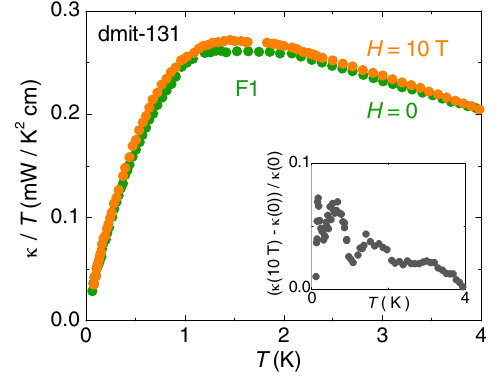
FIG. 7. Thermal conductivity of our sample F1, plotted as κ =T vs T , in both zero field (green) and at H ¼ 10 T (orange), revealing a weak field dependence up to 4 K. Inset: Relative change in κ ð T Þ due to a magnetic field H ¼ 10 T, plotted as ½ κ ð 10 T Þ − κ ð 0 Þ(cid:2) = κ ð 0 Þ vs T